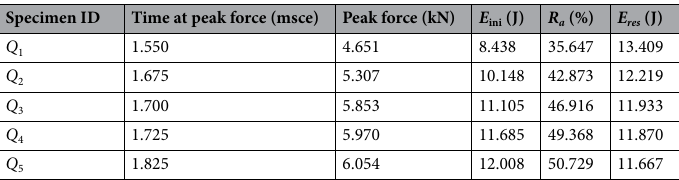
Table 2. Parametric comparisons for low-velocity impact tests for quasi-isotropic composite plates.